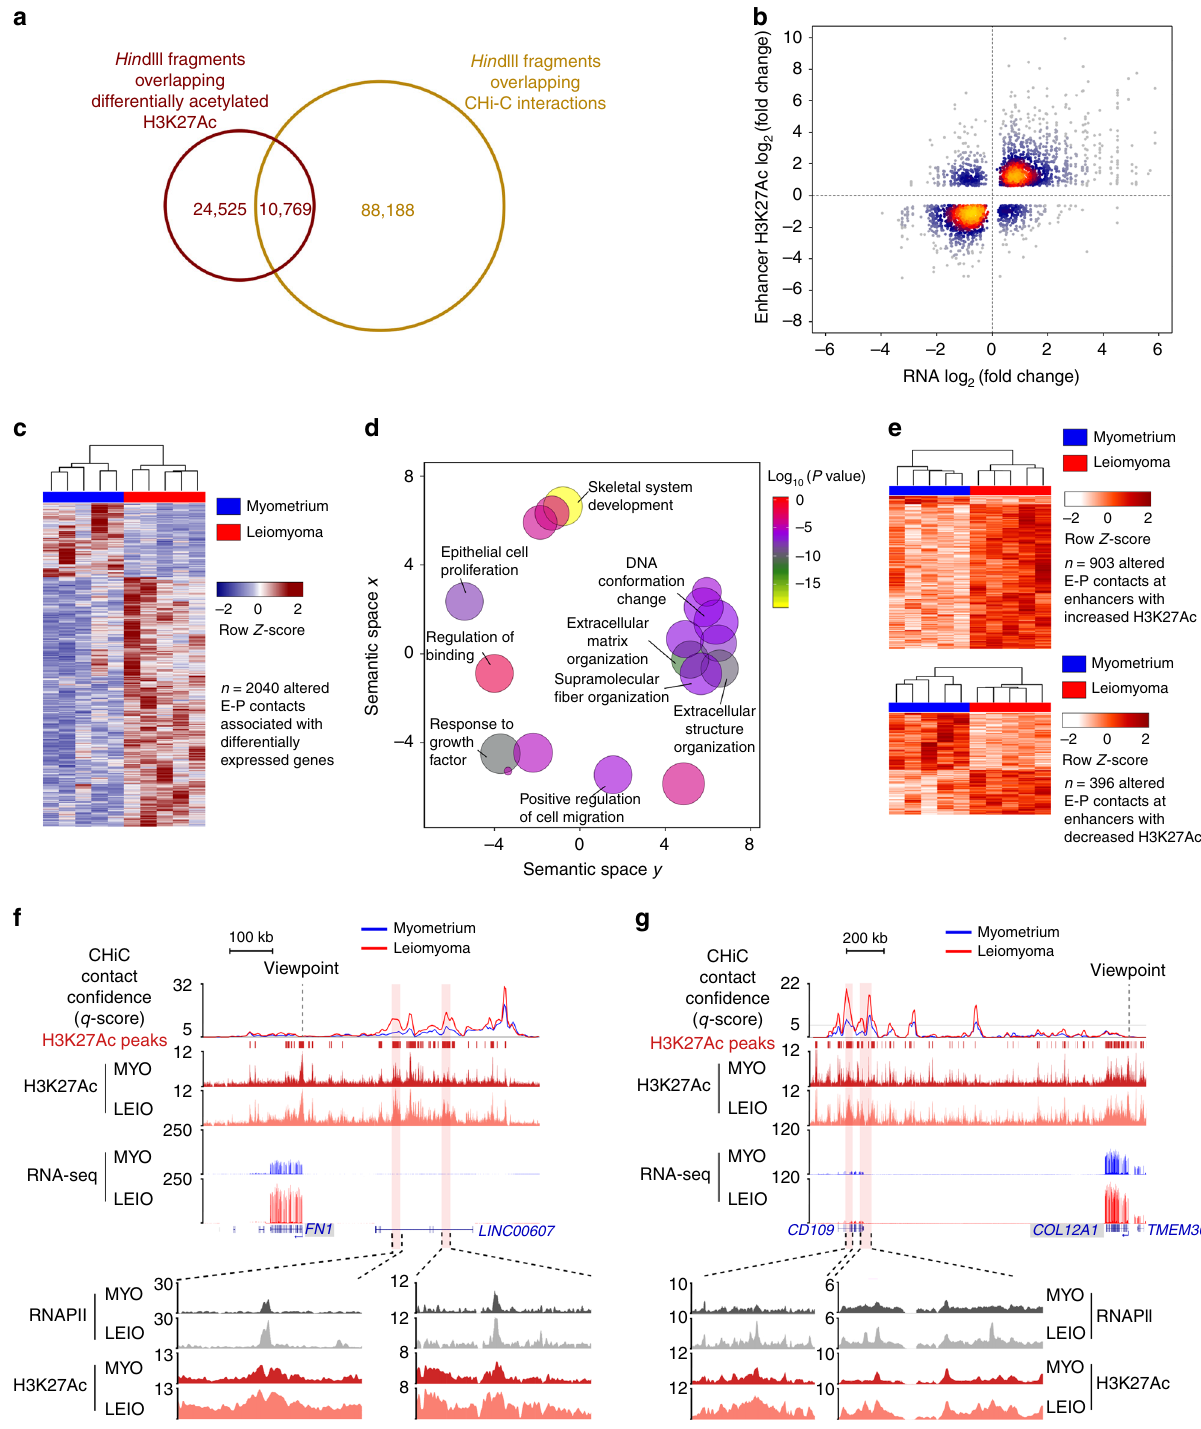
Fig. 3 Enhancer malfunction leads to gene expression changes in leiomyomas. a Venn diagram of promoter contacts overlapping differentially acetylated H3K27 regions in myometrium and leiomyoma tissue. Hin dIII digest fragments of the human genome are used to de fi ne unique, non-overlapping regions in the genome, to which H3K27Ac peaks and promoter contacts are then assigned. See CHi-C data processing and analysis in Methods. b Heat scatter plot of fold change in gene expression against fold change in H3K27Ac signal at enhancers associated with differentially expressed genes ( n = 2715 enhancer regions). c Heat map of altered promoter contacts associated with differentially expressed genes ( n = 2040 contacts). d Scatter plot of con fi dence scores for enriched gene ontologies associated with altered promoter contacts linked to differentially expressed genes, with ontologies clustered by functional similarity in the semantic space. e Heat maps of altered enhancer-promoter contacts that overlap with increasing H3K27Ac (top panel, n = 903 contacts) and decreasing H3K27Ac (bottom panel, n = 396 contacts) at enhancer regions in myometrium and leiomyoma tissues. f , g Genomic loci for FN1 ( f ) and COL12A1 ( g ) genes, which both have unchanged H3K27Ac signal at promoters. Altered con fi dence scores (CHiCAGO q -scores) are shown for myometrium and leiomyoma. In addition, H3K27Ac ChIP-seq and RNA-seq genomic tracks are shown, with H3K27Ac and RNAPII ChIP-seq signal in regions containing altered contacts highlighted (bottom zoomed in